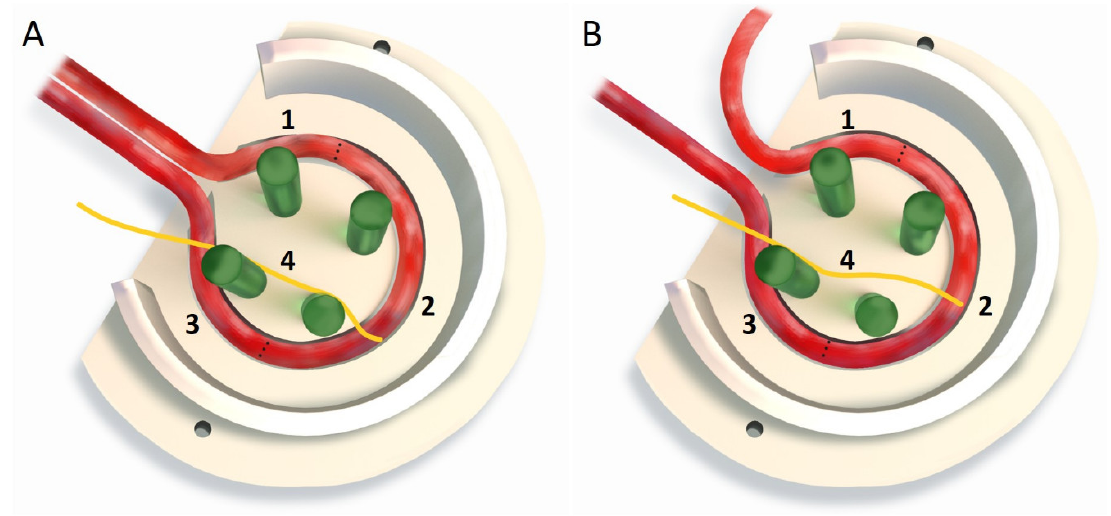
Figure 1. A: Comparison between the newly modified ( A ) and the previously described ( B ) EPI loop model, showing the different entry angles of the arteries into the chamber. EPI loop consisting of SIEA (1), vein interposition (2), SIEV (3) and motoric nerve branch (4) B: EPI loop consisting of saphenous artery (1), vein interposition (2), SIEV (3) and motoric nerve branch (4). For the surgical procedure, a semi-curve incision was made in the left groin while a straight transverse incision was made in the right groin to expose the right SIEV as a vein graft. The left superficial inferior epigastric vessels were localized and freed from the surrounding connective and fatty tissue. The proximal end of the right SIEV was anastomosed to the dissected left SIEV, using interrupted 11-0 microsutures (11-0 Ethilon™, Ethicon, Inc., Raritan, NJ, USA). Subsequently, the left SIEA was also dissected and anastomosed to the distal end of the venous interposition graft as described above, creating the arterio-venous anastomosis. Before opening the clamp attached to the arterial leg, 25 I.U. heparin (Heparin sodium 25000-ratiopharm ® , ratiopharm GmbH, Ulm, Germany) were applied intravenously via the tail vein. After removal of the clamp, loop patency was checked, using the ballooning test, excluding retrograde perfusion.